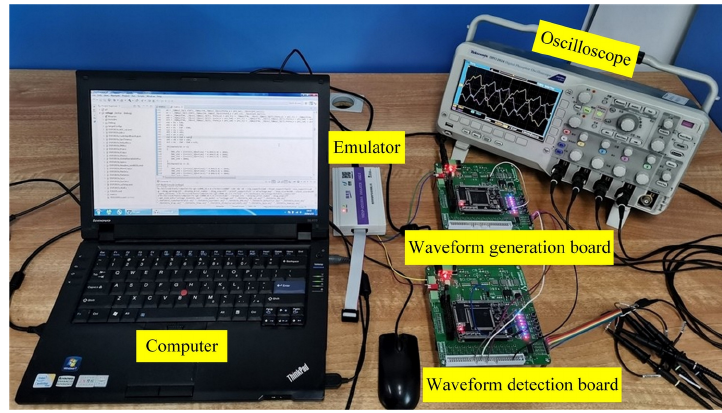
Figure 10. Photo of digital experimental platform.